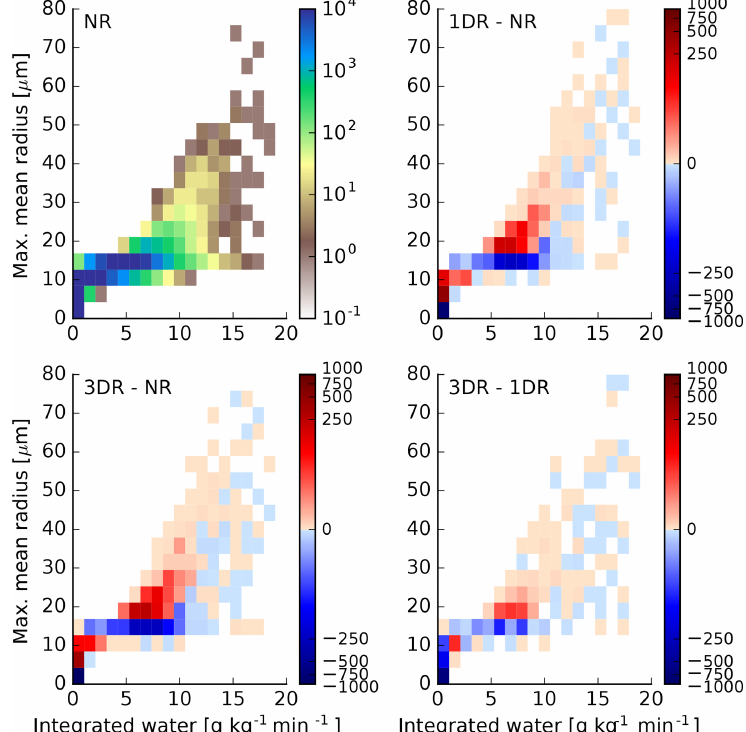
Figure 11. Joint histogram of integrated water and maximum mean radius. The first figure shows all data from the NR simulation. The other figures show the difference of the number of occurrences of 1DR vs. NR, 3DR vs. NR and 3DR vs. 1DR.